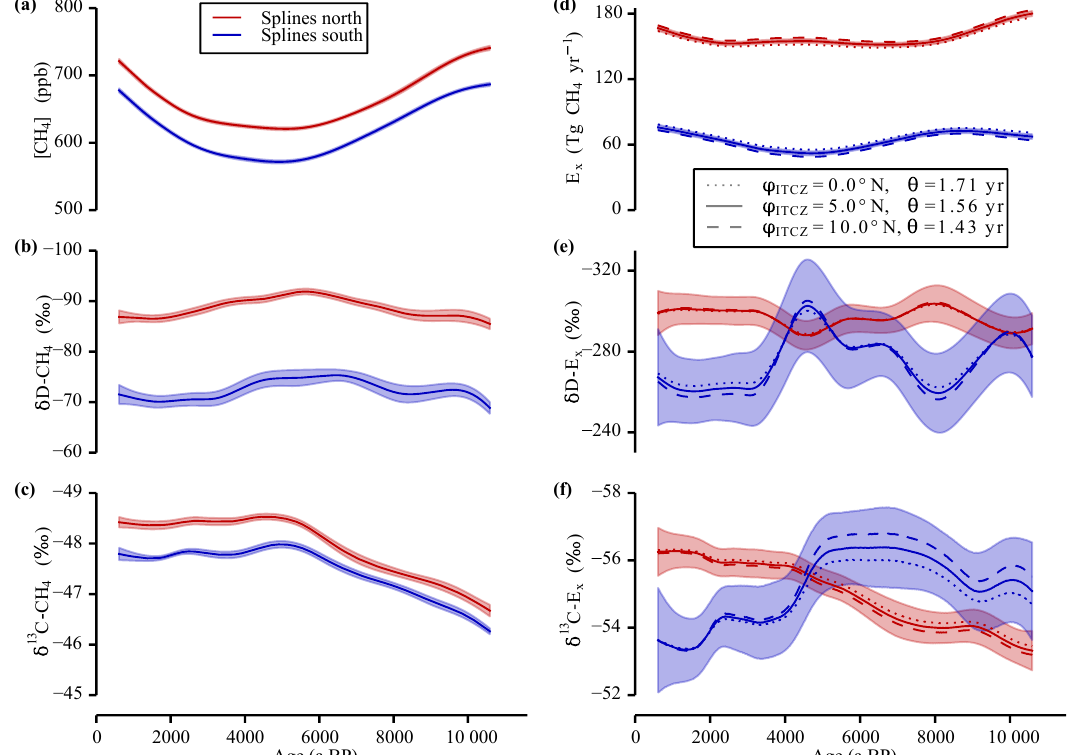
Figure 5. Sensitivity study “SF 6 calibration”. In panels (a–c) the data splines with the 1 σ uncertainty bands of the measured tropospheric values are shown. In panels (d–f) the calculated strengths and the isotopic signature of the emissions are shown for the three different ϕ ITCZ and θ set-ups to investigate the sensitivity of the inversion to the SF 6 calibration. Note the inverted y axes in panels (b) , (c) , (e) , and (f) .